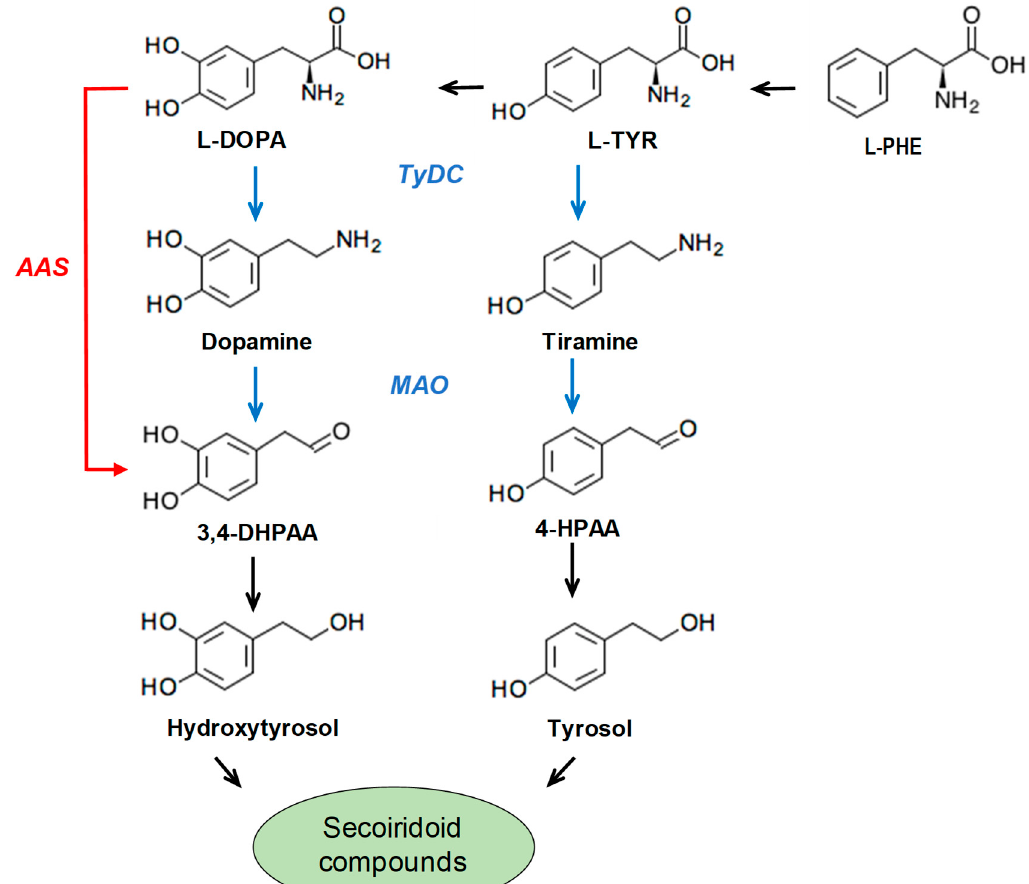
Figure 1. Proposed biosynthesis pathway for the phenolic alcohols hydroxytyrosol and tyrosol, which constitute the phenol moiety of secoiridoid compounds in olive. Abbreviated intermediate metabolites and enzymes are: 3,4 dihidroxyphenylacetaldehyde (3,4-DHPAA); 4-hydroxyphenylacetaldehyde (4-HPAA); Tirosine / Dopa decarboxylase (TyDC); Monoamino oxidase (MAO); Aromatic aldehyde synthase (AAS).